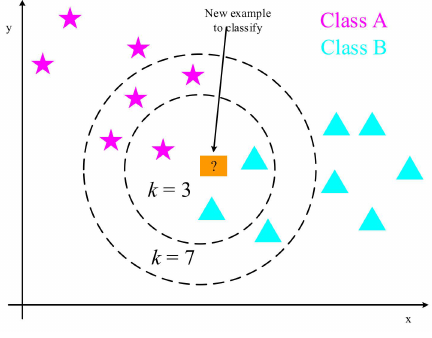
Figure 6. k -nearest neighbors